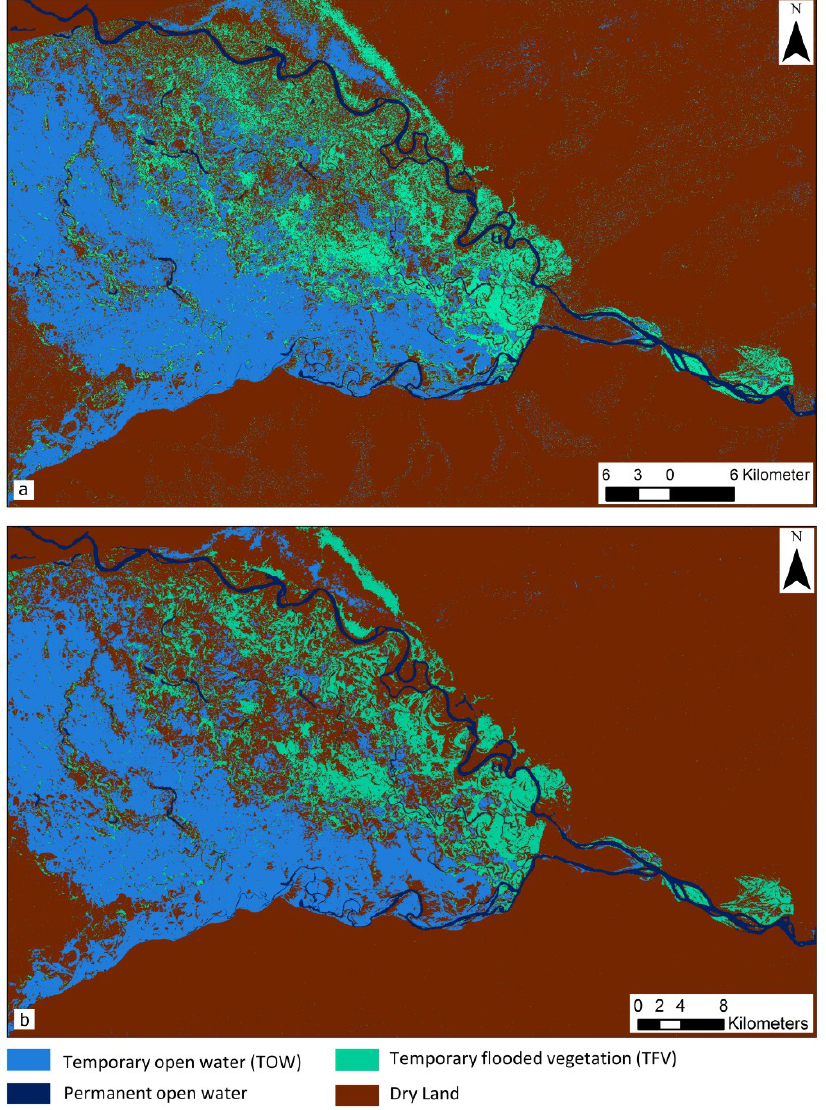
Figure 12. Pixel-based classification result for the entire study area in Namibia ( a ). Object-based classification result for the entire study area in Namibia ( b ).